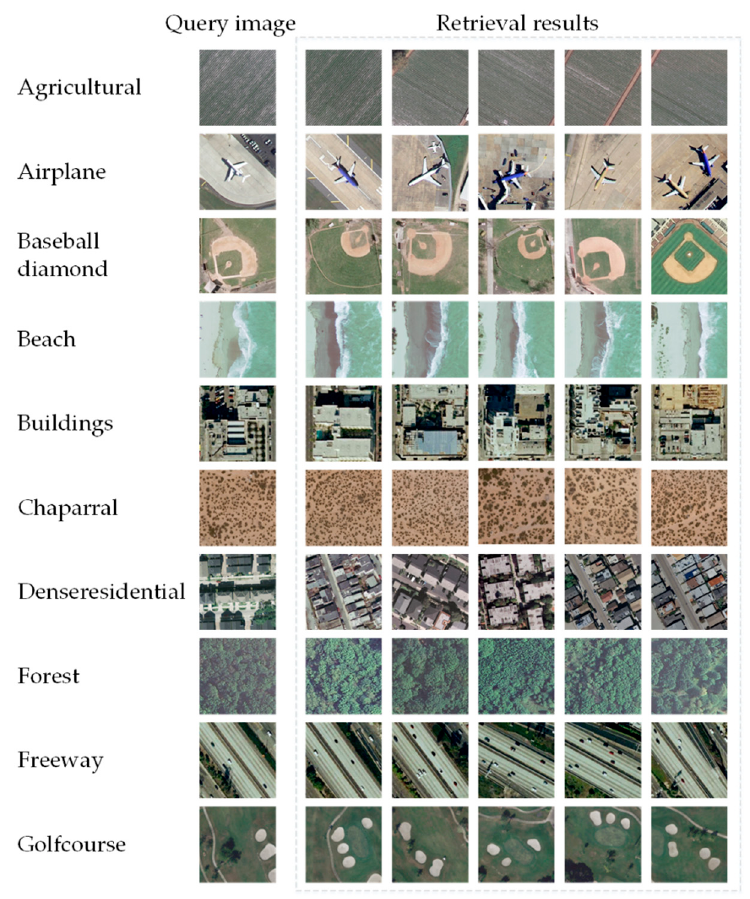
Figure 6. Top five image retrieval results of UCM dataset.